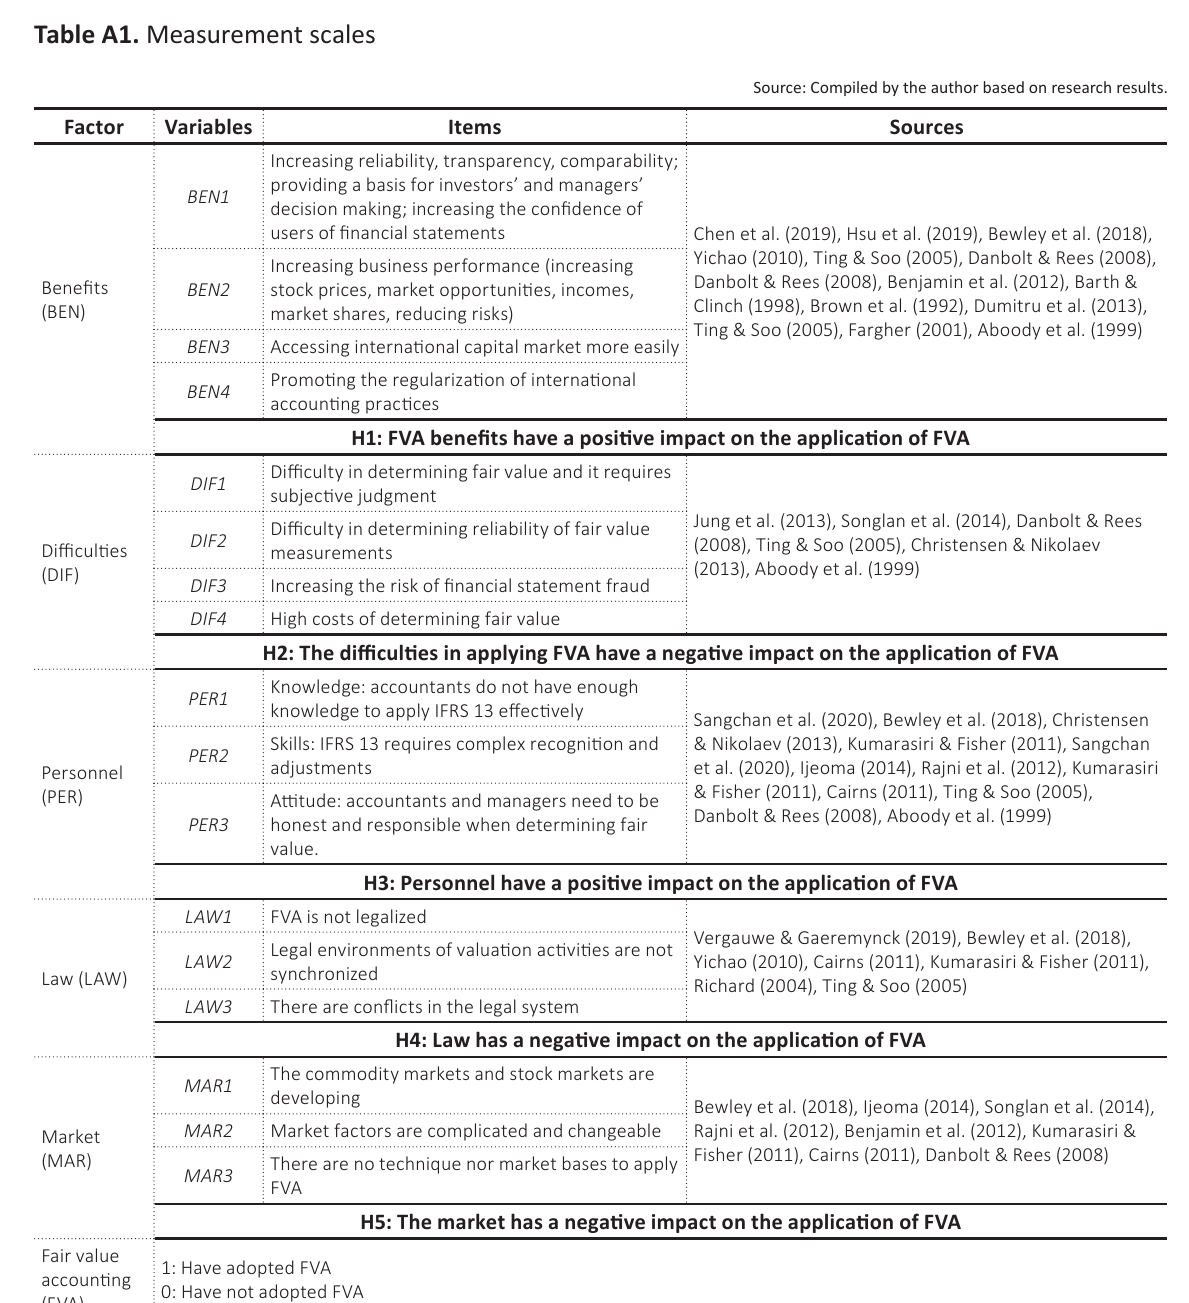
Table A1. Measurement